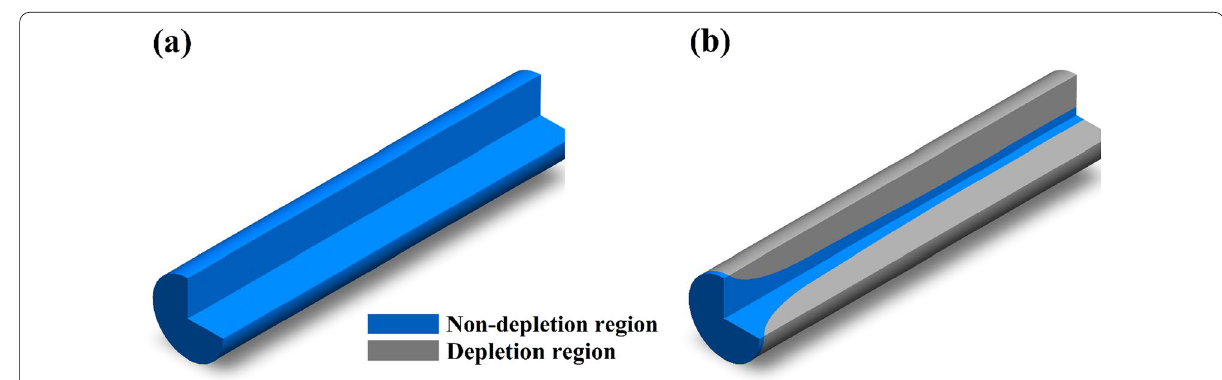
Fig. 1 The distribution of electrons of a ZnO NW in vacuum a and in the air